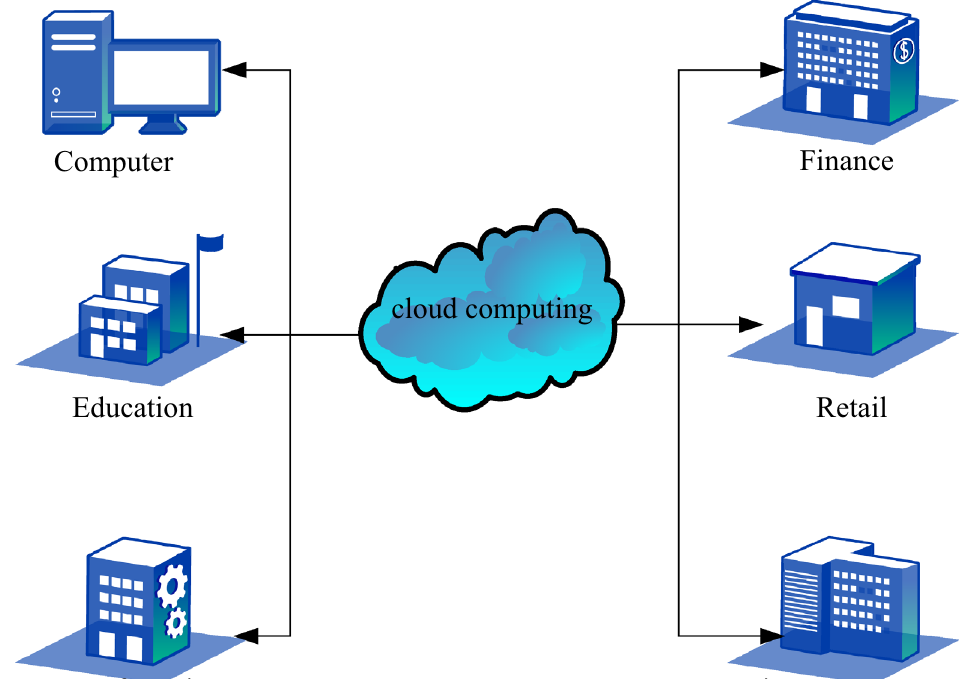
Fig. 1 Application fields of cloud